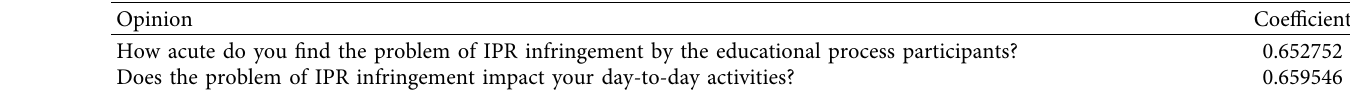
Table 3: Spearmen’s coefficient.